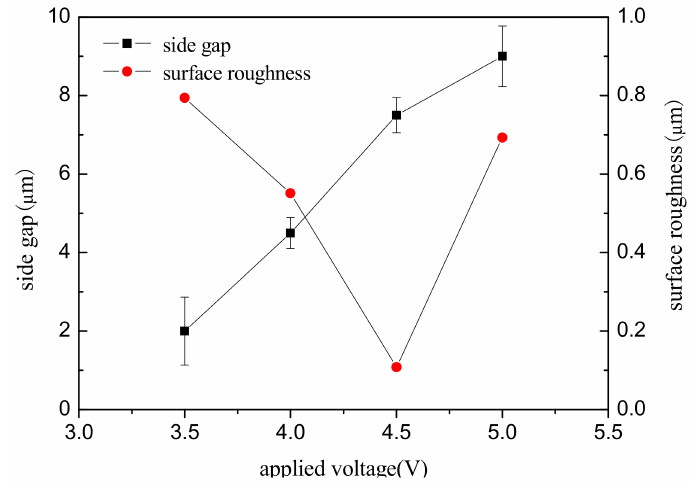
Figure 5. Effect of applied voltage on side gap and surface